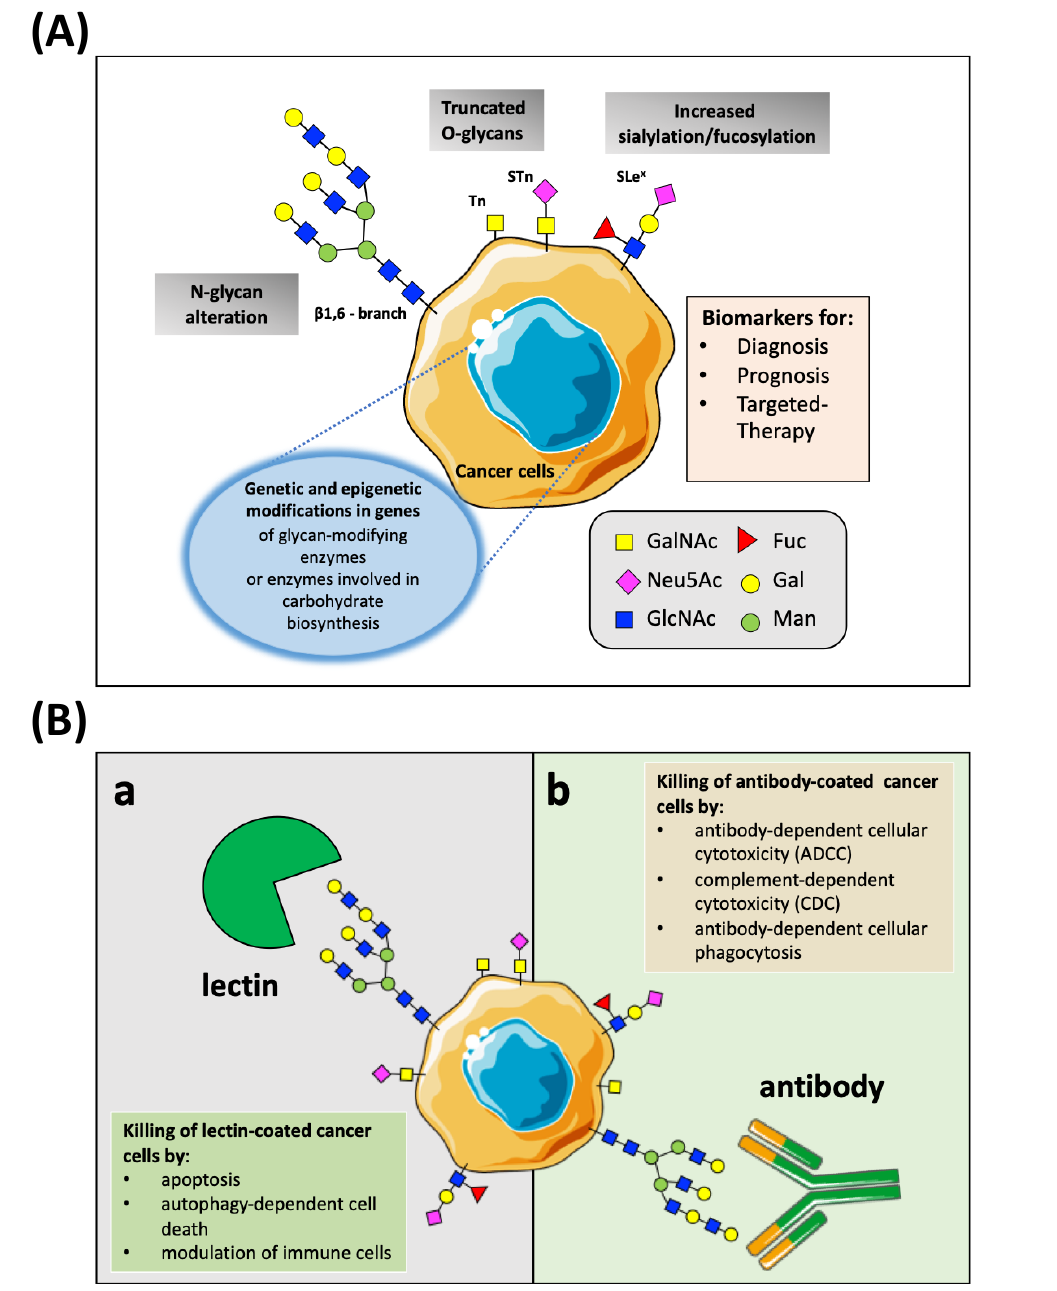
Figure 1. ( A ) . Schematic representation of the characteristic pattern of cancer-associated glycosylation. The three main glycan changes (i.e., altered branching of N-glycans, the expression of truncated O-glycans, and increased sialylation/fucosylation) can be found in cancer due to genetic or epigenetic alterations in genes of glycosylation enzymes-glycosyltransferases and glycosidases. Abbreviations: GalNAc, N-acetylgalactosamine; Neu5Ac, sialic acid; GlcNac, N-acetylglucosamine; Fuc, fucose; Gal, galactose; Man, mannose; Tn, Tn antigen; STn, sialyl-Tn antigen; SLe x , sialyl-Lewis X . ( B ). Overview on the anti-tumor mechanisms of natural lectins and anti-glycan antibodies that can be advantageous for the cancer nanomedicine. ( a ) The binding of lectins to tumor-associated carbohydrates antigens present on the surface of cancer cells elicits cell killing through apoptosis, autophagy, and immunomodulatory activity against cancer. ( b ) Abs can recognize TACAs and induced cell death via different mechanisms, such as antibody-dependent cellular cytotoxicity, complement-dependent cytotoxicity, and antibody-dependent cellular phagocytosis.